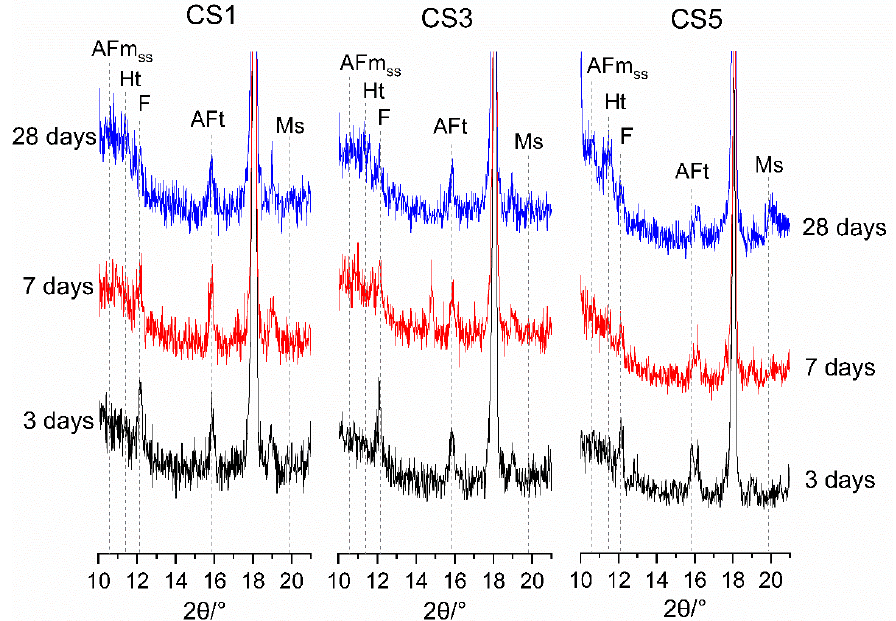
Figure 10. XRD patterns highlighting the phases from 10° to 21° for hydrated slag pastes. F—C 4 AF,